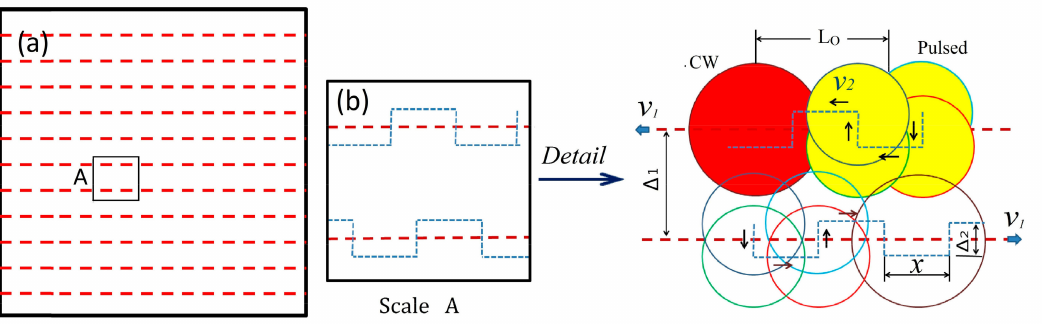
Figure 8. Trajectory of two lasers: ( a ) zigzag of CW laser ( b ) square-wave of pulsed laser.